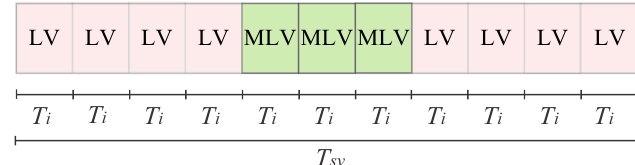
Figure 6. Timing diagram for VV11 technique.